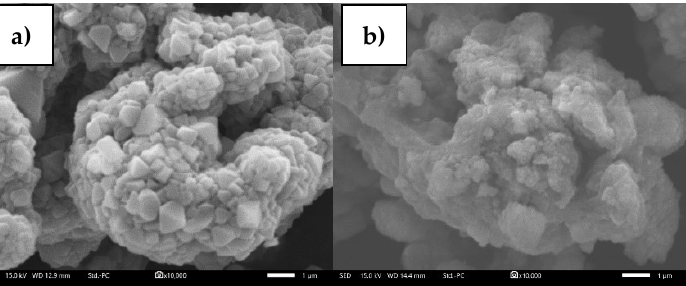
Figure 12. Scanning Electron Microscope images ×10000 magnification of NMC622; ( a ) Precycle, ( b ) Postcycle.